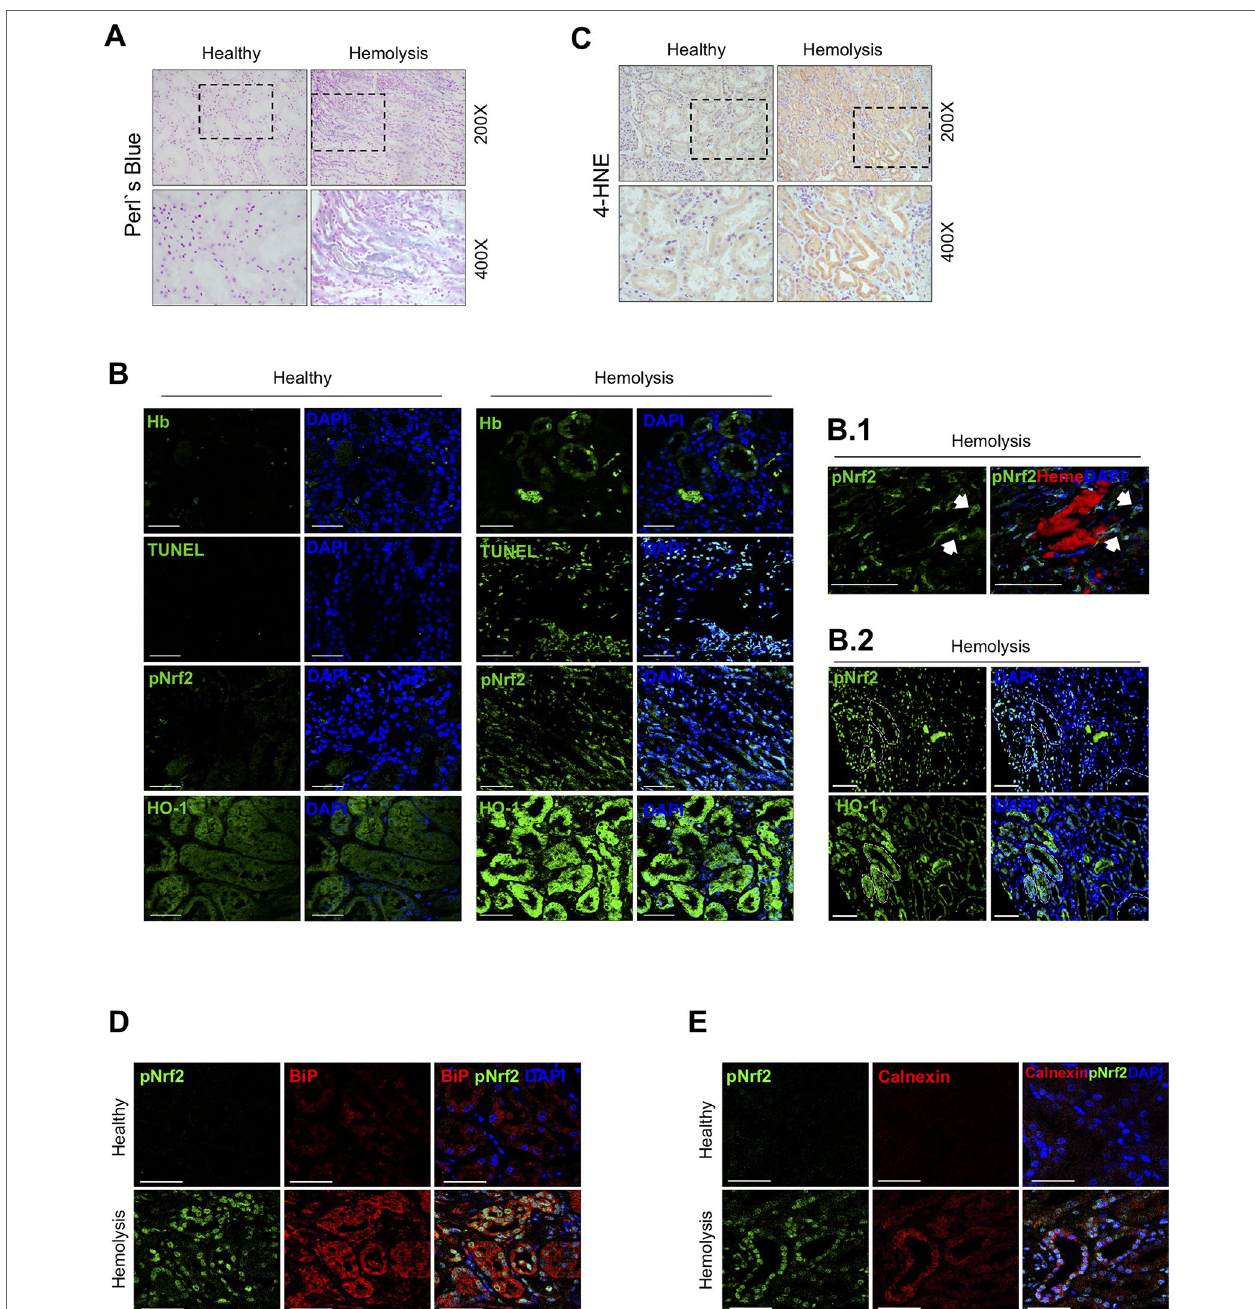
FIGURE 1 | Nuclear factor erythroid-2-related factor 2 (Nrf2) activation in a patient with massive intravascular hemolysis-associated acute kidney injury (AKI). (A) Representative image of Perls’ Prussian blue staining showing iron accumulation in the renal biopsy of a patient with massive intravascular hemolysis as compared with healthy control (200× upper panel, 400× lower panel). (B) Representative confocal microscopy images showing Hb accumulation (green, first row), terminal deoxynucleotidyl transferase (TdT) dUTP nick-end labeling (TUNEL)-positive cells (green, second row), phospho-Nrf2 (green, third row), and HO-1 (green, fourth row). Nuclei were stained with 4 ′ -6-diamidino-2-phenylindole (DAPI) (blue); scale bar, 100 μm. B.1. Representative confocal microscopy images showing the presence of heme cast (red) and nuclear phospho-Nrf2 (green); scale bar, 50 μm. B.2. Representative serial immunofluorescence images showing nuclear Nrf2 translocation (phospho-Nrf2, green) in HO-1-rich areas. White circles indicate similar regions in serial immunostained sections. Scale bar, 100 μm. (C) Representative image of 4-hydroxynonenal (4-HNE) staining (200× upper panel, 400× lower panel). Representative confocal microscopy images showing the presence of nuclear Nrf2 translocation (phospho-Nrf2, green) and the endoplasmic reticulum stress markers BiP ( red, D) and calnexin ( red, E) . Scale bar, 50